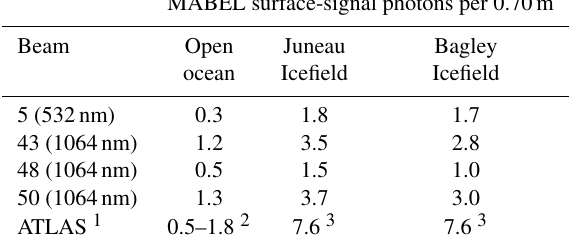
Table 1. MABEL along-track signal photon densities over the open ocean and the Juneau and Bagley